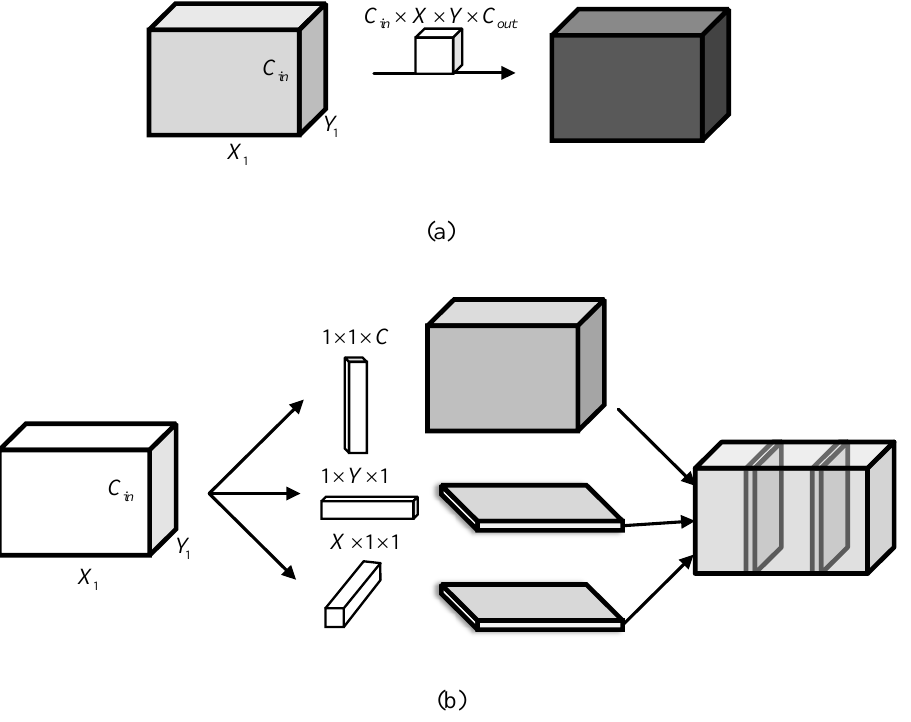
Figure 5. The structure of the traditional convolution and the dimension-wise convolution. ( a ) Traditional convolution. ( b ) Dimension-wise convolution.